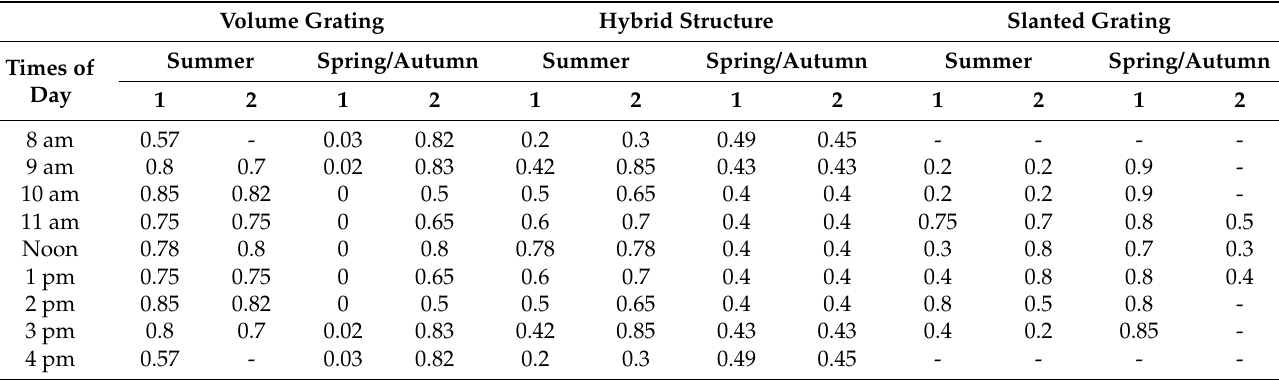
Table 1. Efficiency of different types of structures, taking into account the trajectory of the Sun for St. Petersburg during the spring–autumn period.